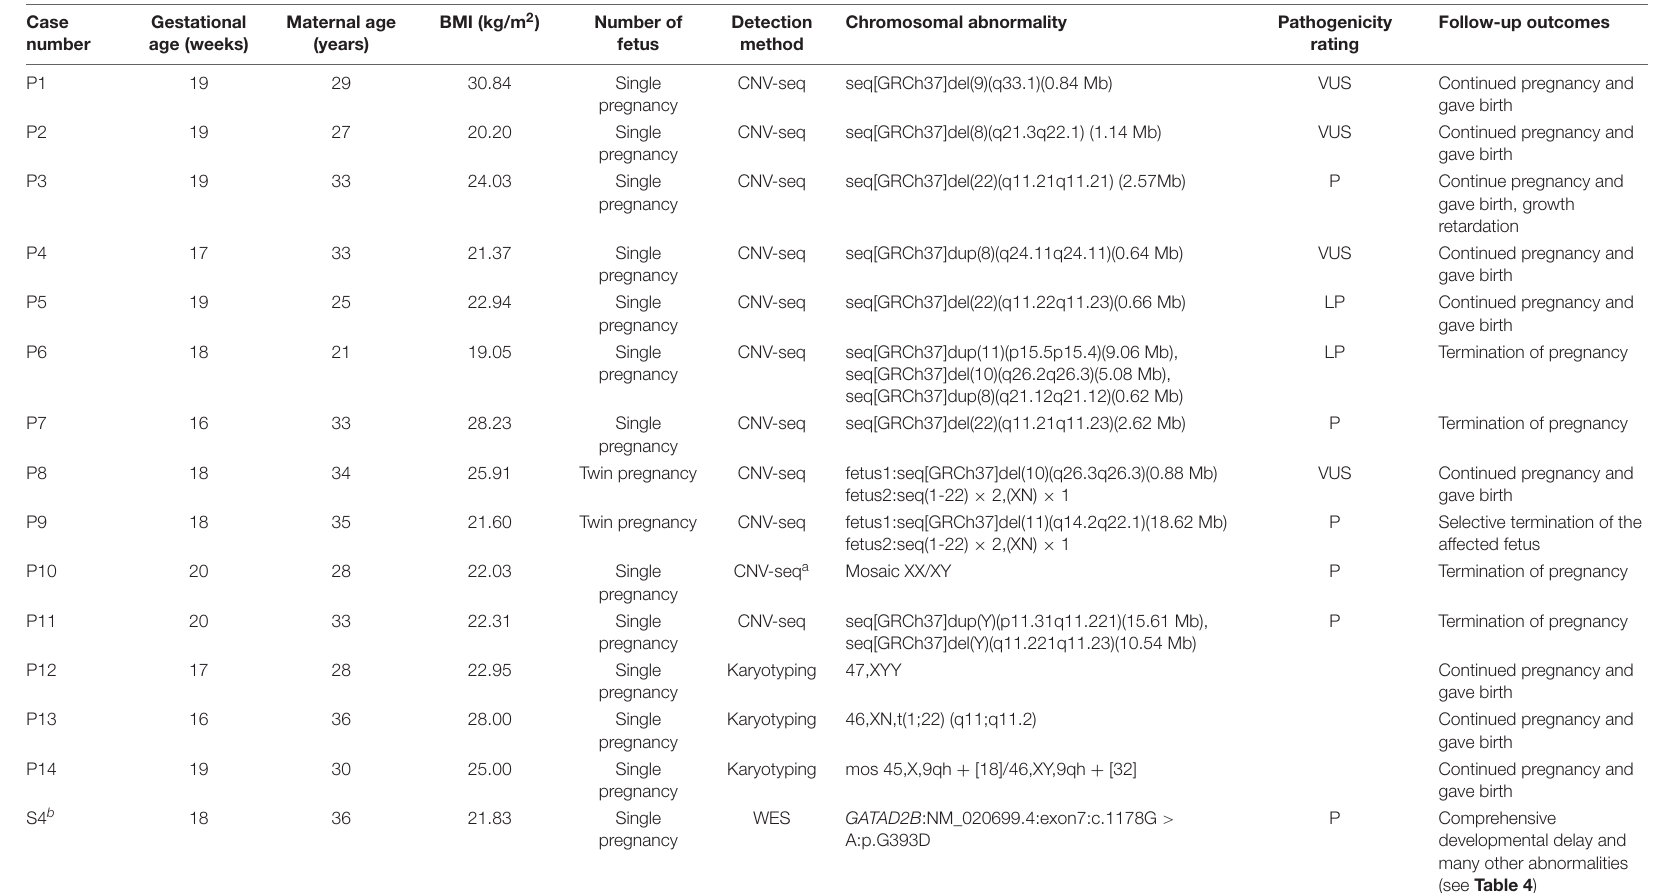
TABLE 2 | All chromosome abnormalities detected in 378 NIPS test